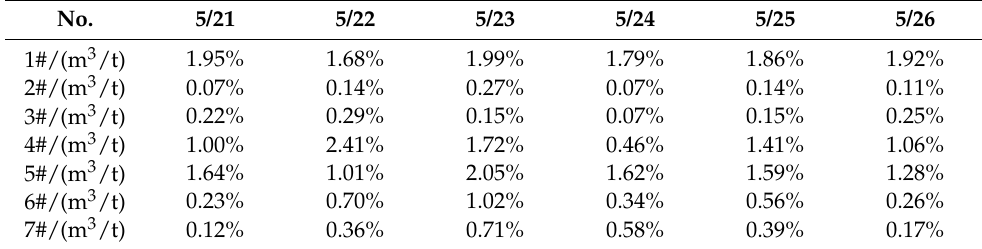
Figure 7. Comparison of gas prediction and actual data in the intake and return air roadways of the working face. ( a ) 4# location; ( b ) 5# location; ( c ) 6# location; ( d ) 7# location.